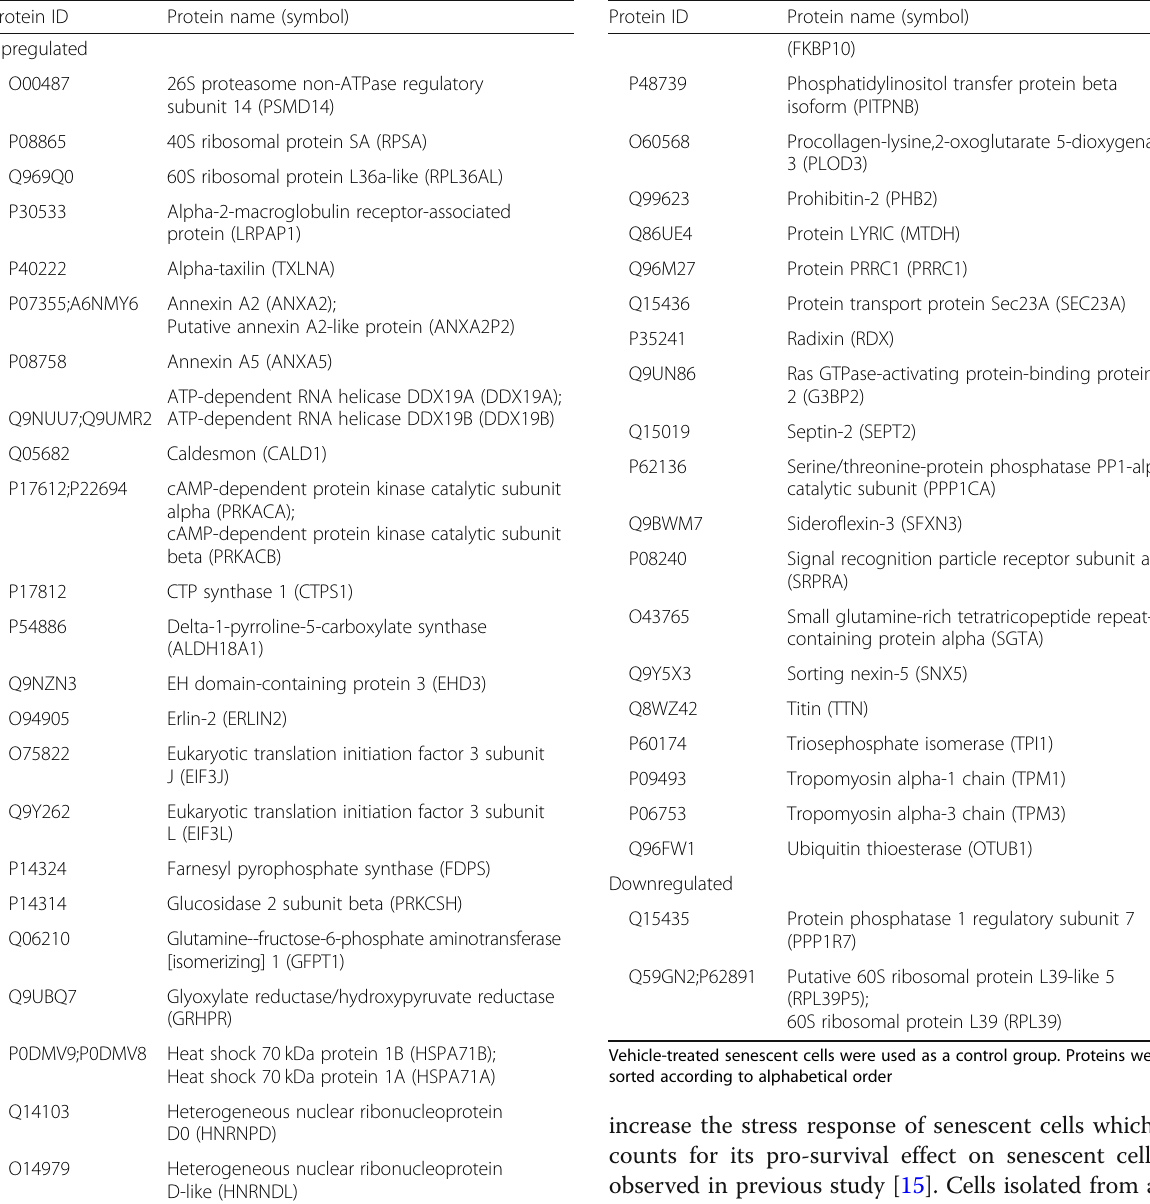
Table 2 List of differentially expressed proteins in vehicle- and γ T3-treated senescent cells Protein ID